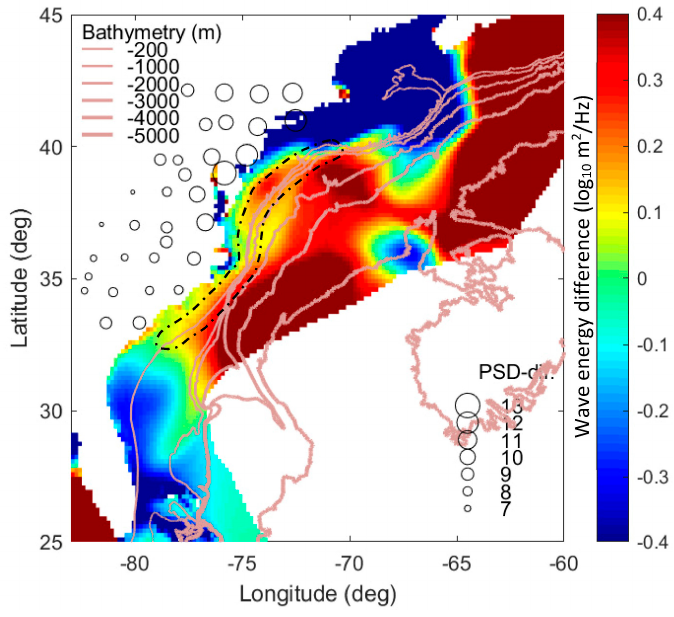
Figure 6. Di ff erence of the ocean wave energy ( E ( F / 2) in log 10 (m 2 / Hz)) and PSD levels between day 329 Figure 6. Difference of the ocean wave energy ( E ( F /2) in log 10 (m 2 /Hz)) and PSD levels between day and 331 (Figure 4c,e, 329 and 331 (Figure 4c,e, respectively).